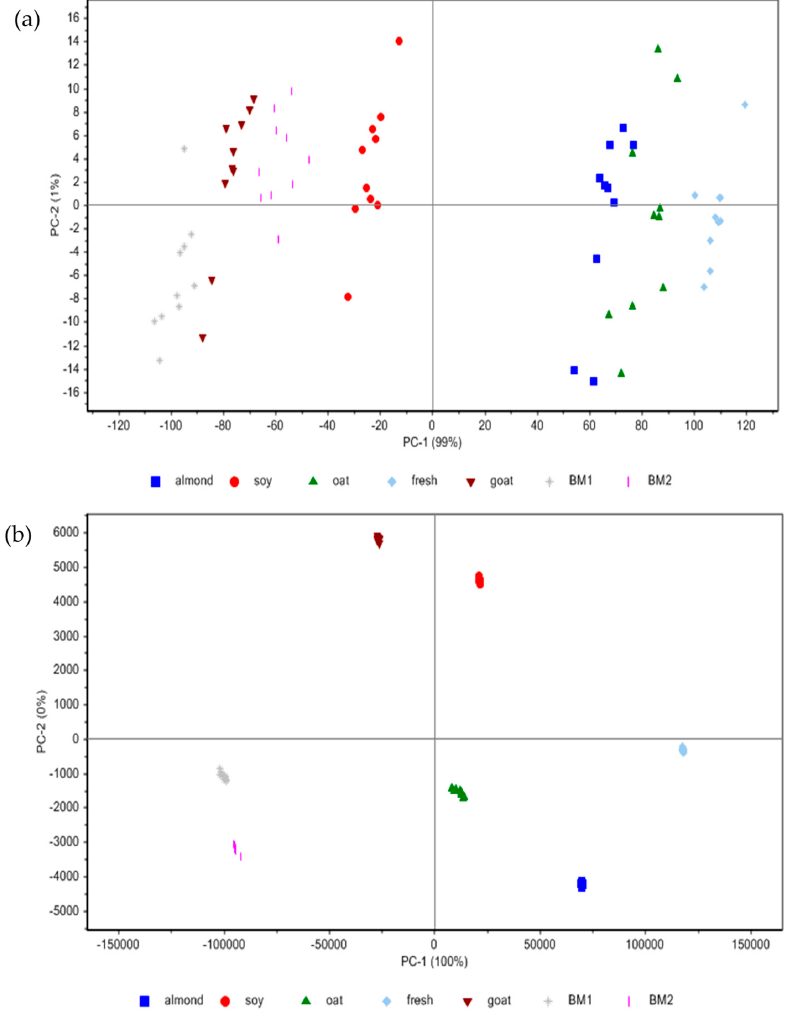
Figure 4. The principal component analysis (PCA) of fluorescence spectra through ( a ) NIR spectrometer and ( b ) VIS-NIR spectrometer (BM is a short form for human breast milk).